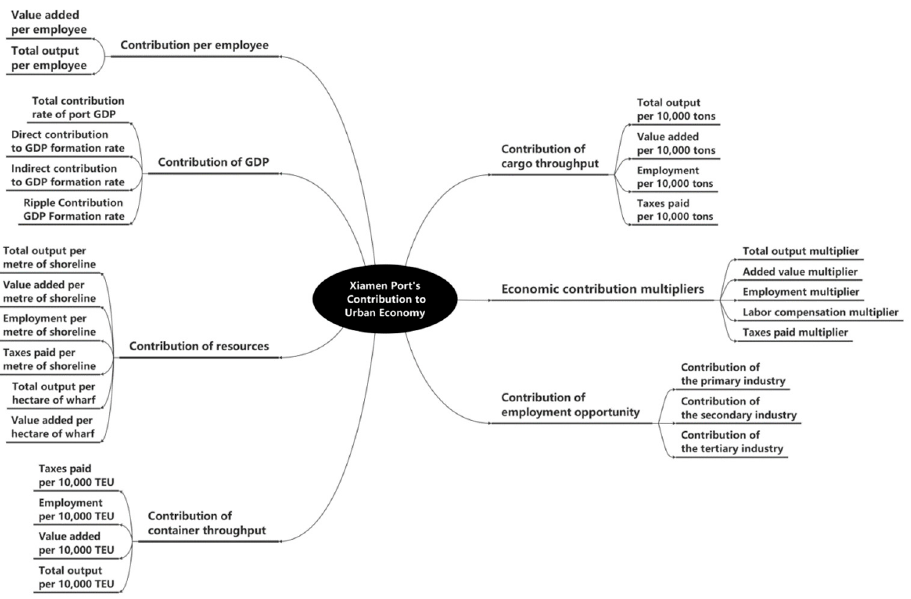
Figure 3. Indicators for evaluating economic the contribution of Xiamen Port to the city.